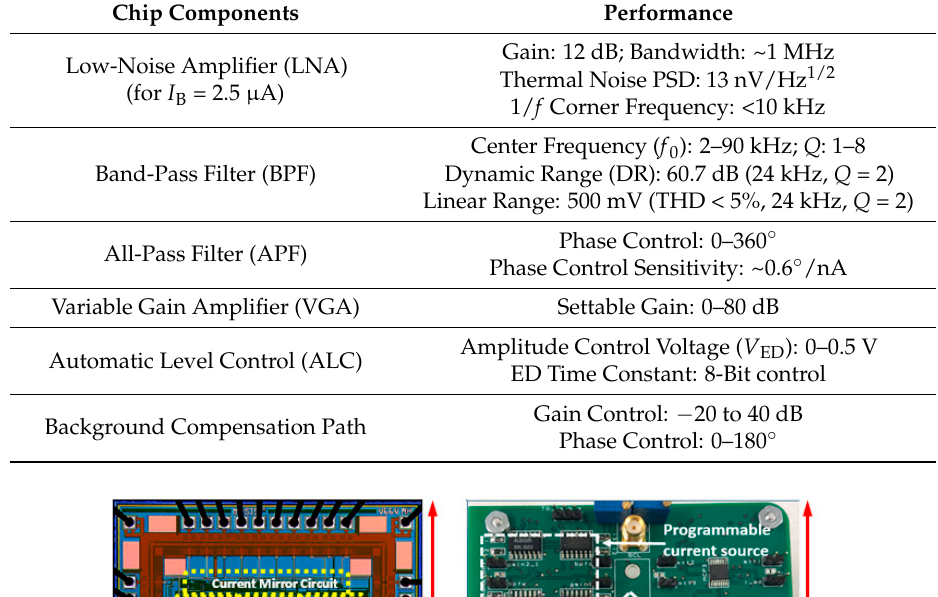
Summary of the electrical specifications and performance of the programmable sustaining amplifier.